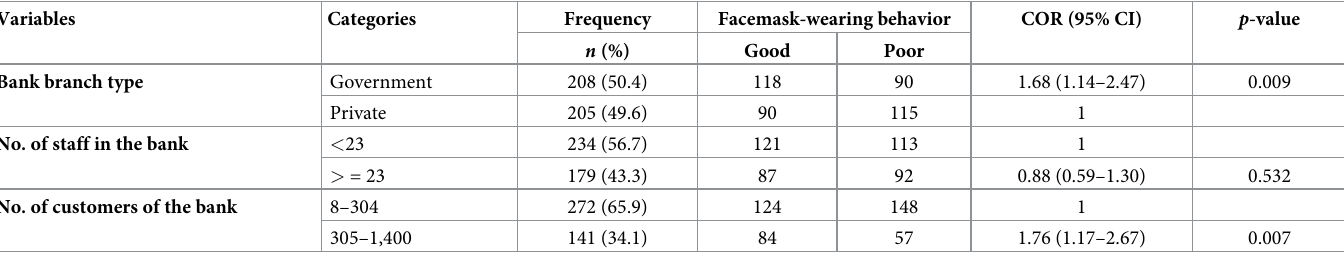
Table 2. Bank environment-related factors and bivariable analysis with facemask-wearing behaviors among bank workers in Dessie City, Ethiopia, January